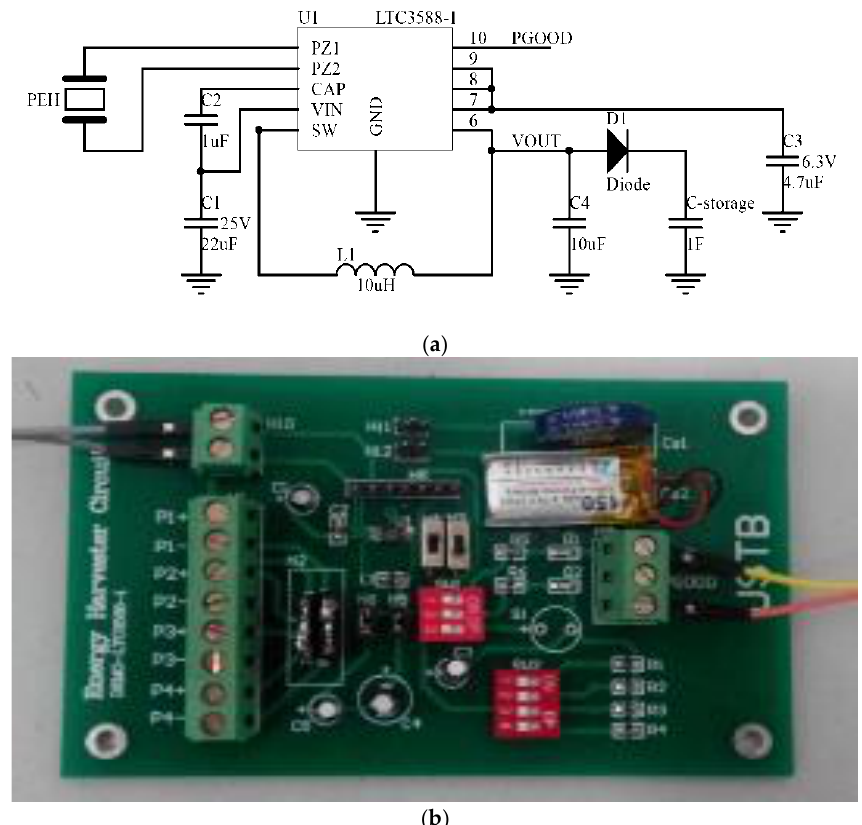
Figure 7. Piezoelectric energy collection circuit. ( a ) Schematic of the circuit. ( b ) The PCB of the circuit.